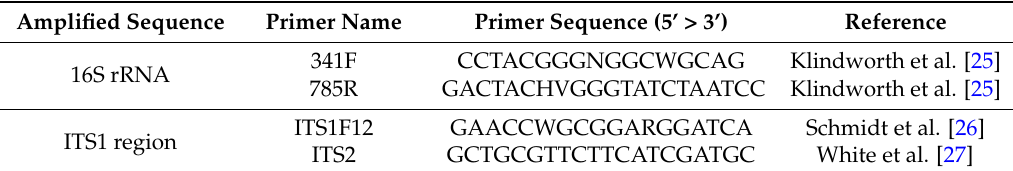
Table 2. Sequences of primers used in this